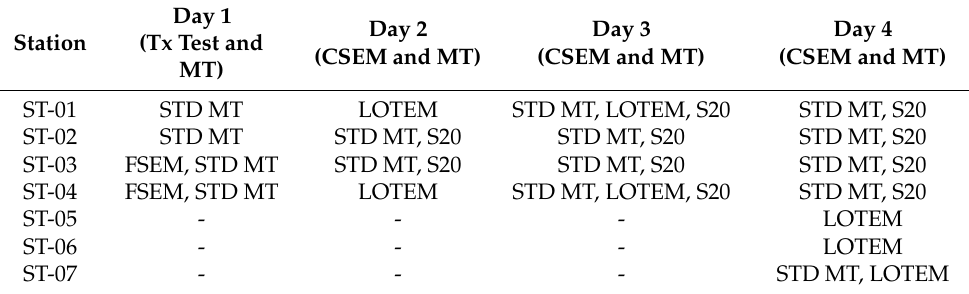
Table 2. Types of EM measurements applied by site and for each